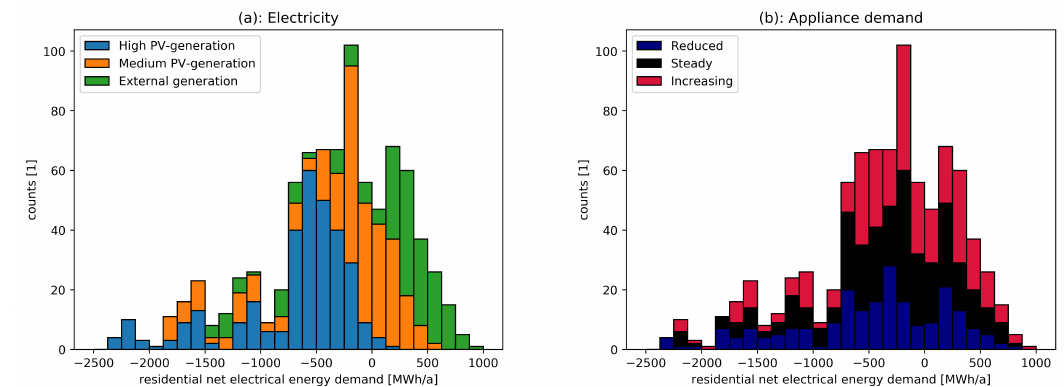
Figure 10. Electricity sector related factors within the scenario space: ( a ) local generation; and ( b ) appliance demand.